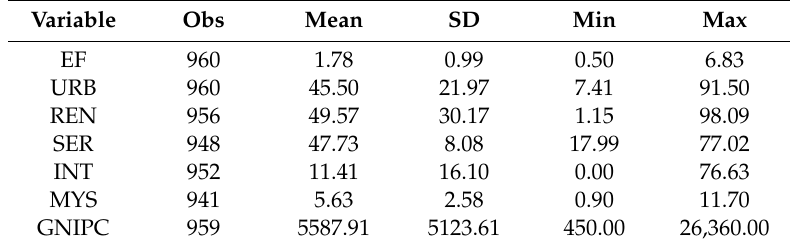
Table 7. Statistical descriptions of the variables for the developing countries